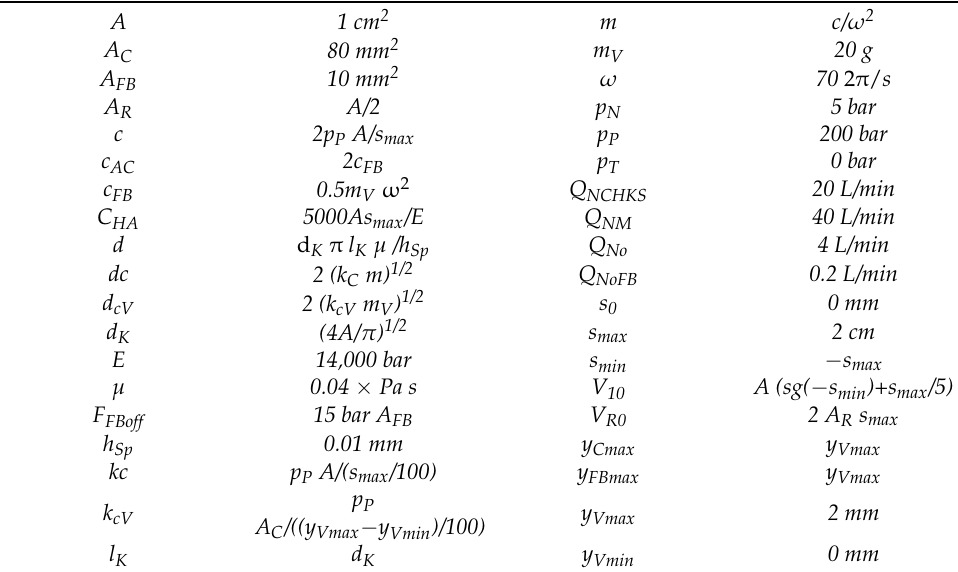
Table 1. Parameter values for